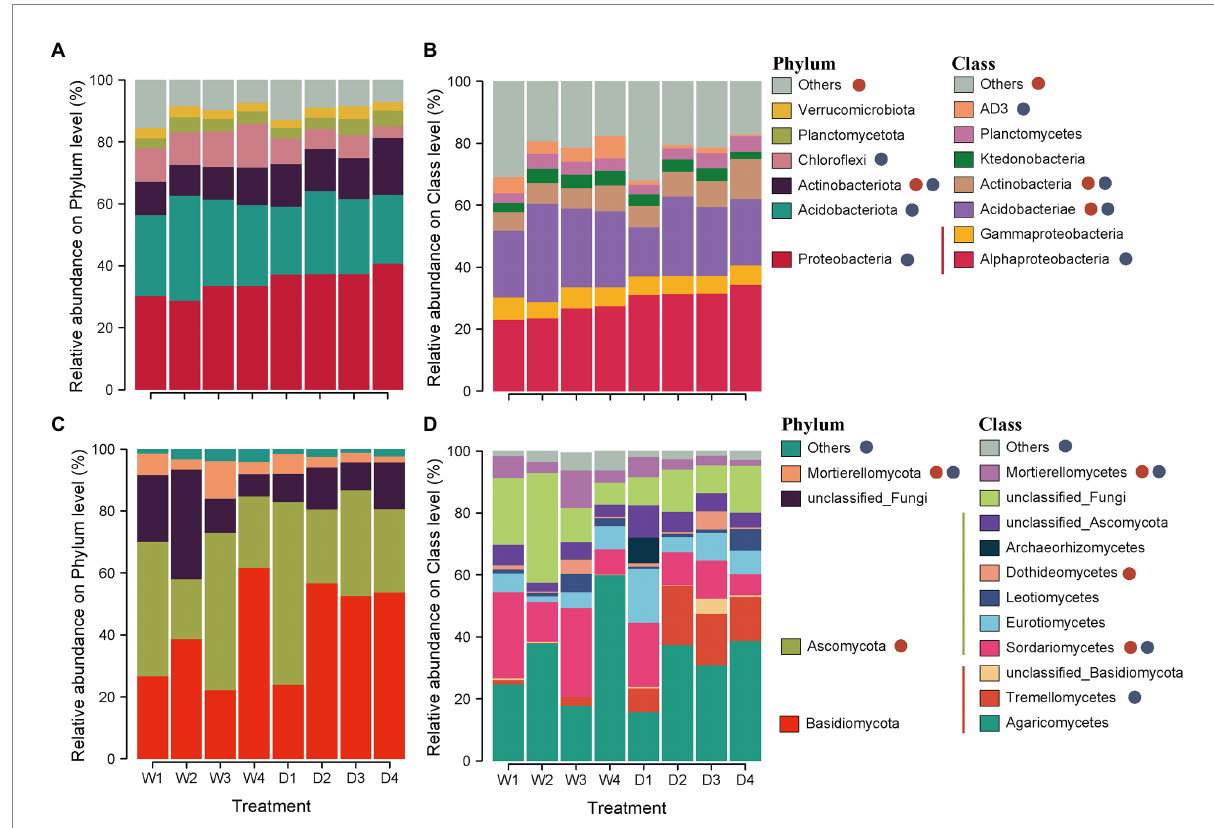
FIGURE 1 Relative abundances of dominant soil bacterial and fungal phyla (A,C) and classes (B,D) in different stages of forest succession and seasons. D1, D2, D3 and D4 represent the initial, early, middle, late stages of forest succession in dry season, while W1, W2, W3 and W4 denote the initial, early, middle, late stages of forest succession in wet season. Red and blue circles indicate the significant differences among different stages of forest succession and seasons,